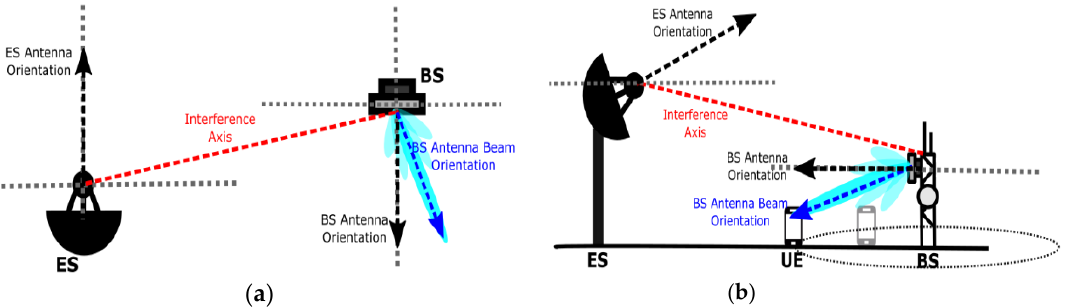
Figure 2. Carrier frequency set to the center frequency in the ( a ) azimuthal and ( b ) elevation planes [6]. During the simulation, we used a three-dimensional (3D) (X, Y, Z) coordinate system to present the results. In this coordinate system, the x - and y -axes represent the latitude and longitude coordinates of the BS, respectively, and the z -axis represents the target mea-